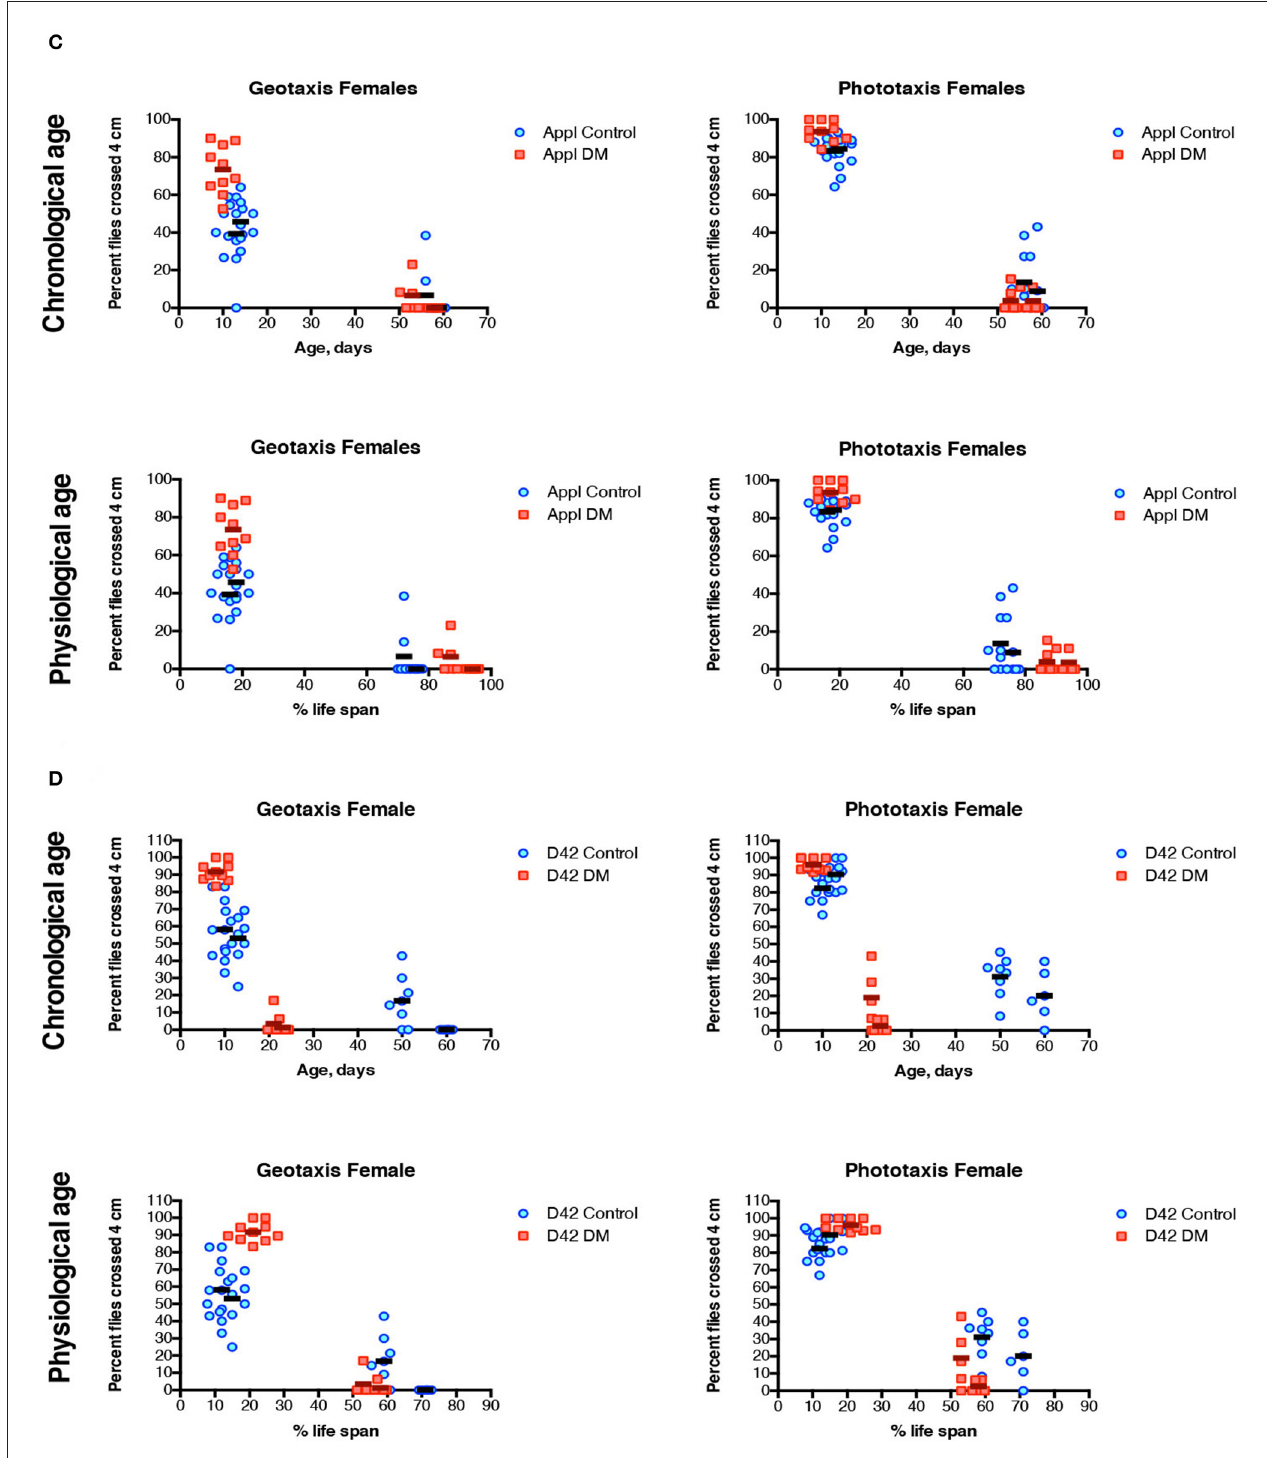
FIGURE 2 | Negative geotaxis and phototaxis of DM flies under-expressing dPrx3 pan-neuronally (A,C) and in motor neurons (B,D) . The measurements were performed at different ages as indicated in Supplementary Table 1 . Results are represented for each single measurement of two experiments with independent cohorts with mean values. The abbreviations and genotypes of flies are described in Table 1 . To evaluate the differences in age-dependent changes in sleep-wake behavior parameters between controls and the DM fly lines regression curve slopes and intercepts were compared ( Table 3 ).